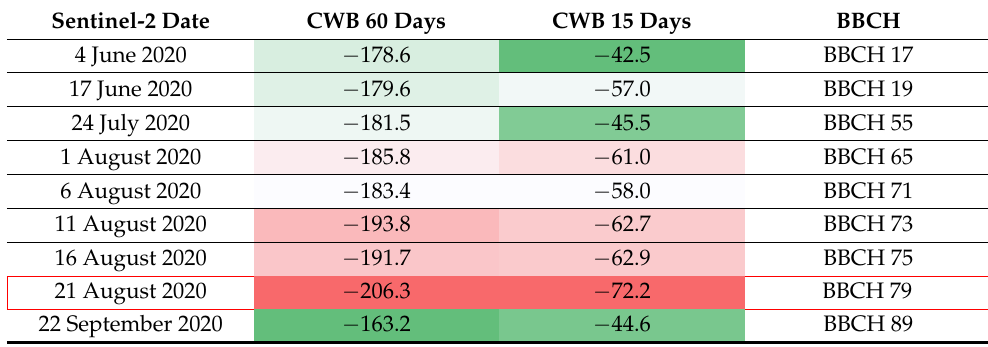
Table 5. Date list of analyzed images with CWB in 60-day and 15-day